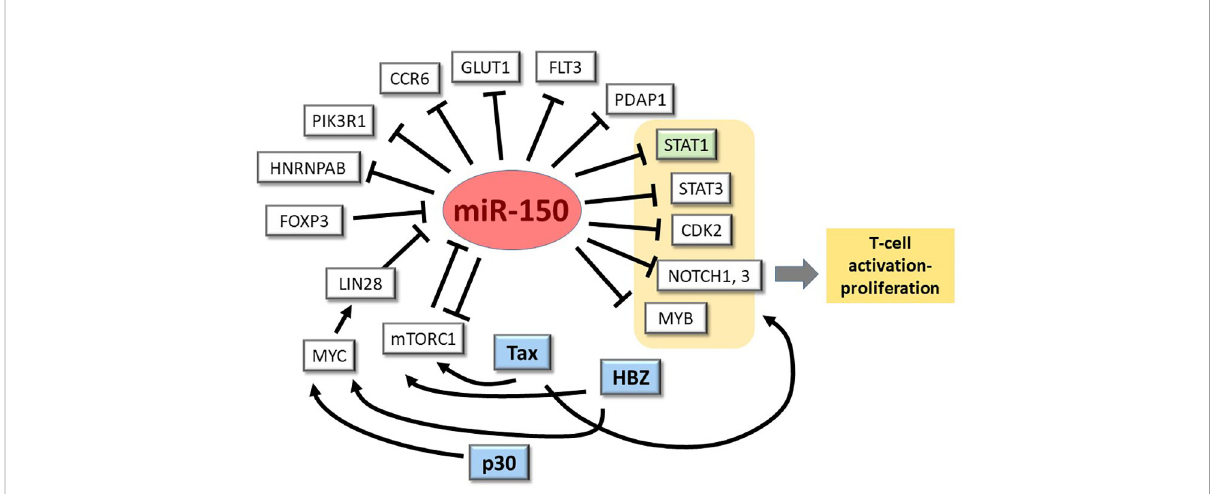
FIGURE 2 miR-150-mRNA interactions in HTLV-1 infection/transformation: one con fi rmed, many to explore. miR-150 is known to repress expression of STAT1 (highlighted in green) when overexpressed in ATLL cell lines (24). As depicted here and described in the text, many other genes of potential relevance to HTLV-1 infection and pathogenesis are known to be controlled by miR-150 in normal and neoplastic T-cells and other leukocyte